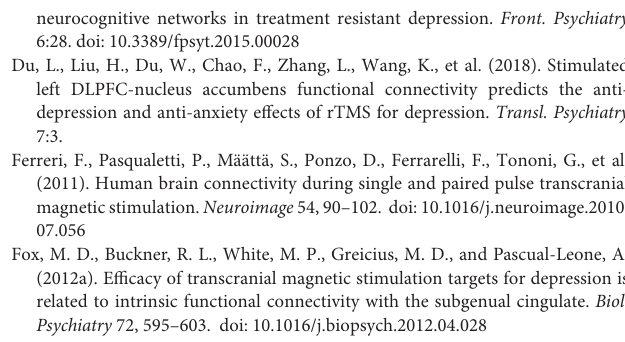
Supplementary Figure 1 | When the coordinates of the left DLPFC were located at the center of BA9, (A) one sample t -test showed positive functional connectivity between left DLPFC and bilateral insula. (B) The correlations between the connectivity and the clinical efficacy of rTMS were not significant. Supplementary Figure 2 | When the coordinates of the left DLPFC were located at the center of BA46, (A) one sample t -test showed positive functional connectivity between left DLPFC and bilateral insula. (B) The correlations between the connectivity and the clinical efficacy of rTMS were not